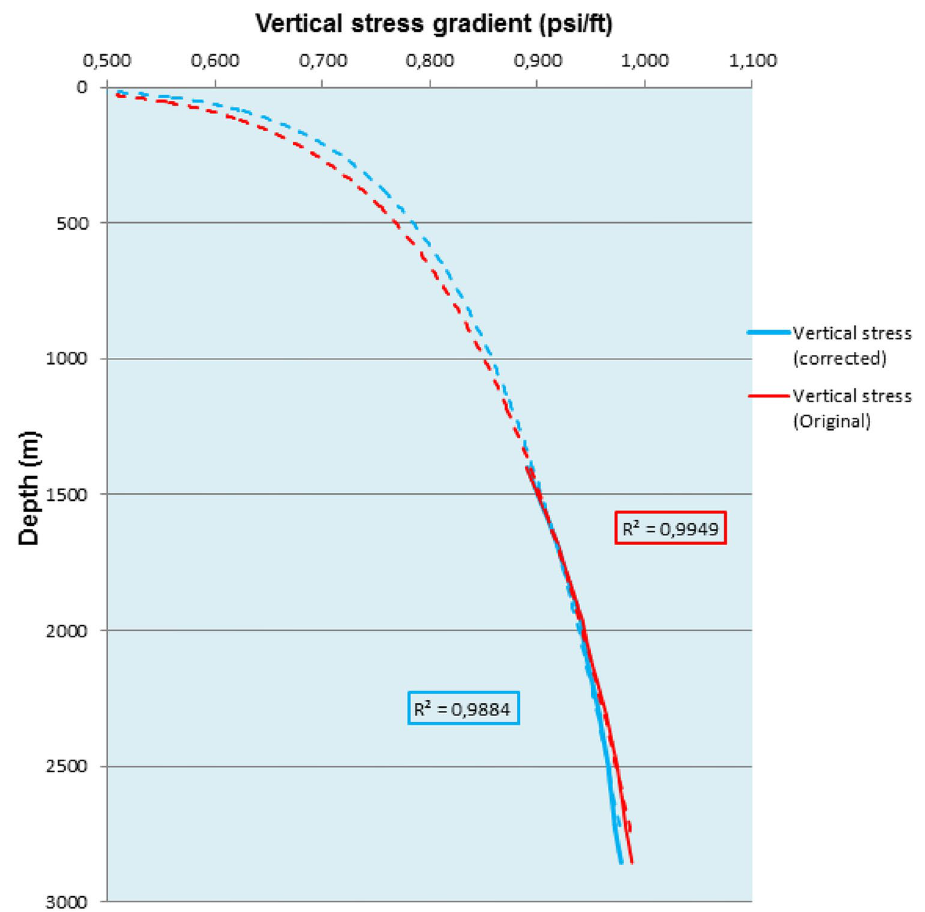
Fig. 5 Example of graph showing vertical stress gradient before and after density correc- tion with depth for well